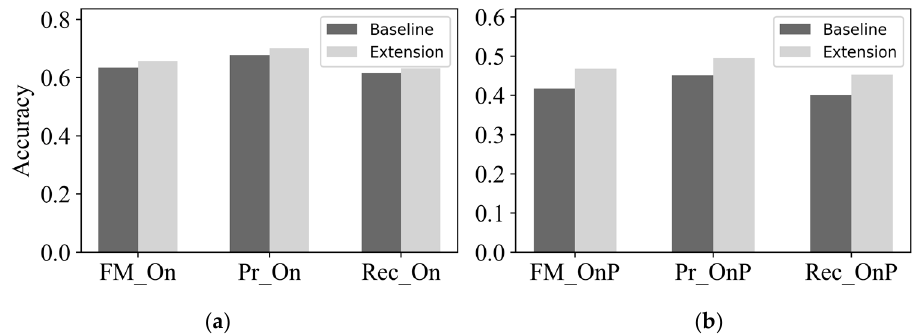
Figure 11. Singing transcription result from MIREX2020 in baseline system and extension system: ( a ) shows our on results, ( b ) shows our OnP results.